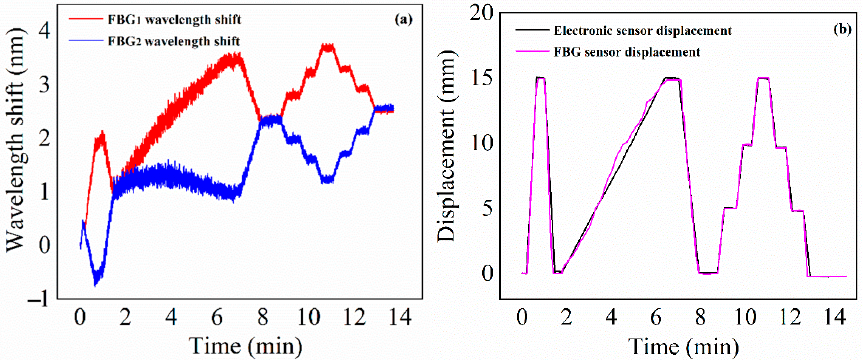
Figure 10. ( a ) FBG wavelength shift with displacement and temperature; ( b ) displacement compar-